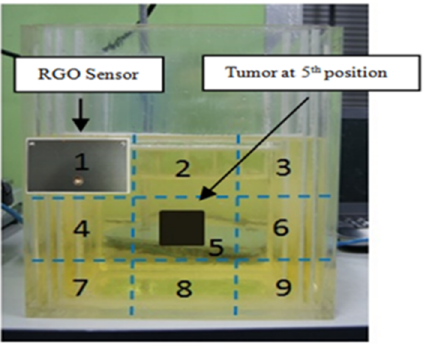
Figure 11. Human head phantom scanning area.